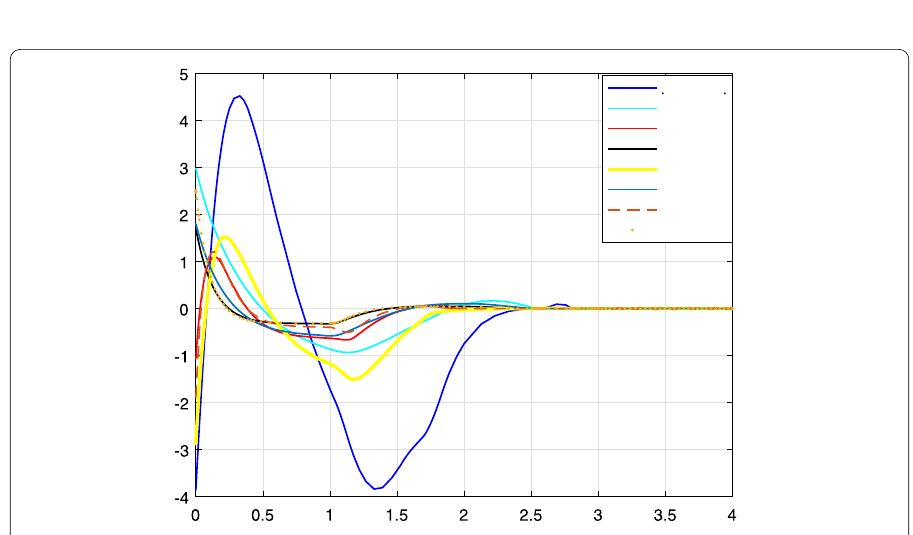
Figure 2 Time evolution of synchronization errors e 1 ( t ), e 2 ( t ), e 3 ( t ), e 4 ( t ) with